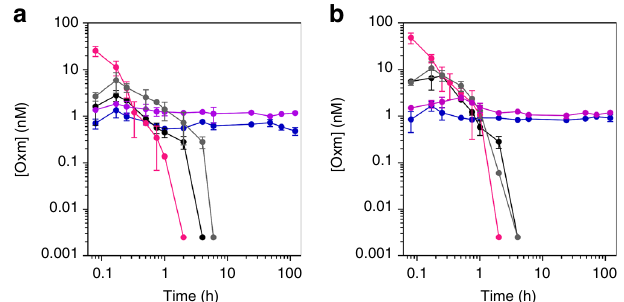
Fig. 7 Pharmacokinetic pro fi les following administration of free and fi brillar Oxm. Oxm bioactivity in rat serum determined using in vitro cell-based cAMP bioassay for determining GLP-1 a and GCG b receptor agonist bioactivity after administration of 5 mg kg − 1 of free Oxm i.v. (magenta), s.c. (black), and fi brillar Oxm s.c. (blue) and 10 mg kg − 1 of free Oxm s.c. (gray) and fi brillar Oxm s.c. (violet). The data correspond to the average measurements from 3 rats ±